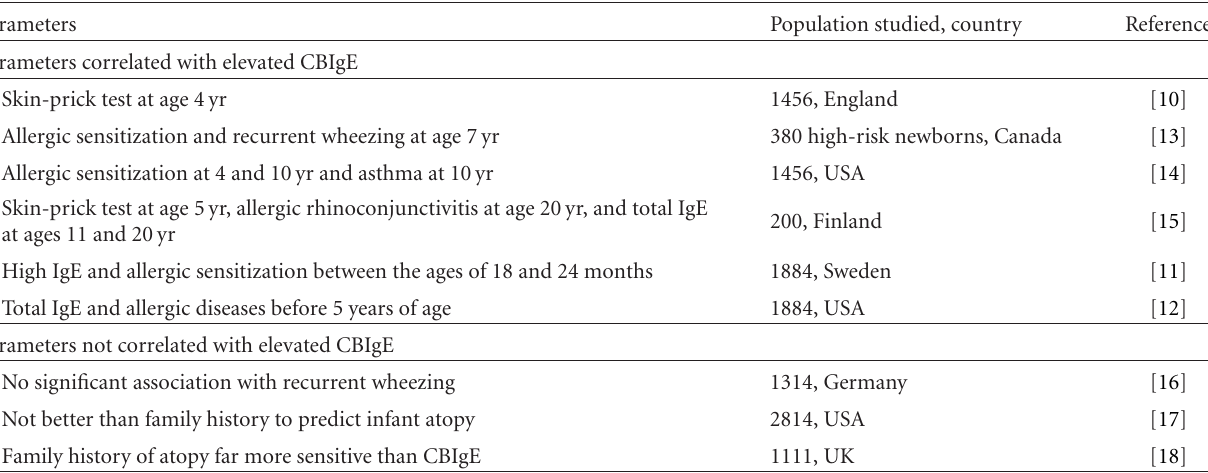
Table 1: Does CBIgE elevation predict